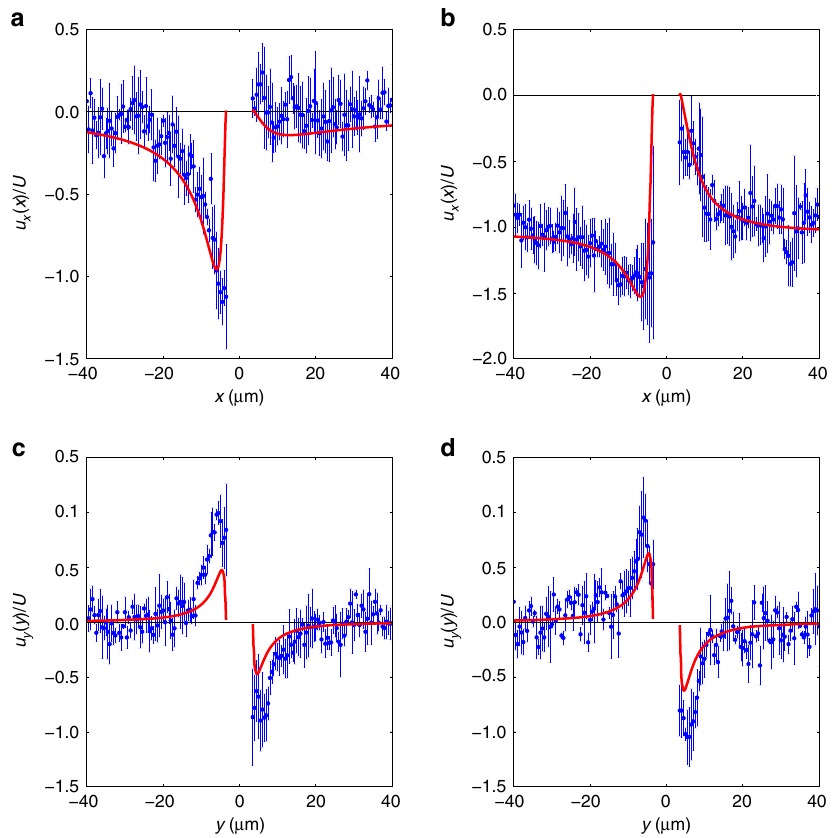
Fig. 4 Two components of the velocity fi eld. x -component of the velocity measured at y = 0 and as a function of the coordinate x for the two situations where the swimmer is stuck ( a ) and freely moving ( b ). y -component of the velocity measured at x = 0 and as a function of the coordinate y for the two situations where the swimmer is stuck ( c ) and freely moving ( b ). For all plots, the blue symbols and error bars are obtained experimentally after averaging the fi elds measured in a stripe of width 2 μ m around y = 0 ( a , b ) and x = 0 ( c , d ). The red line is a fi t of the experimental data using the expressions of the velocity given in the Methods section (Eqs. (15) and (17)), with K = v 0 / U as a free parameter. The expansions in Legendre polynomials are truncated at order N = 25. The values of the fi t parameters are K stuck = 11.6 ± 0.7 and K moving = 15.2 ± 0.7